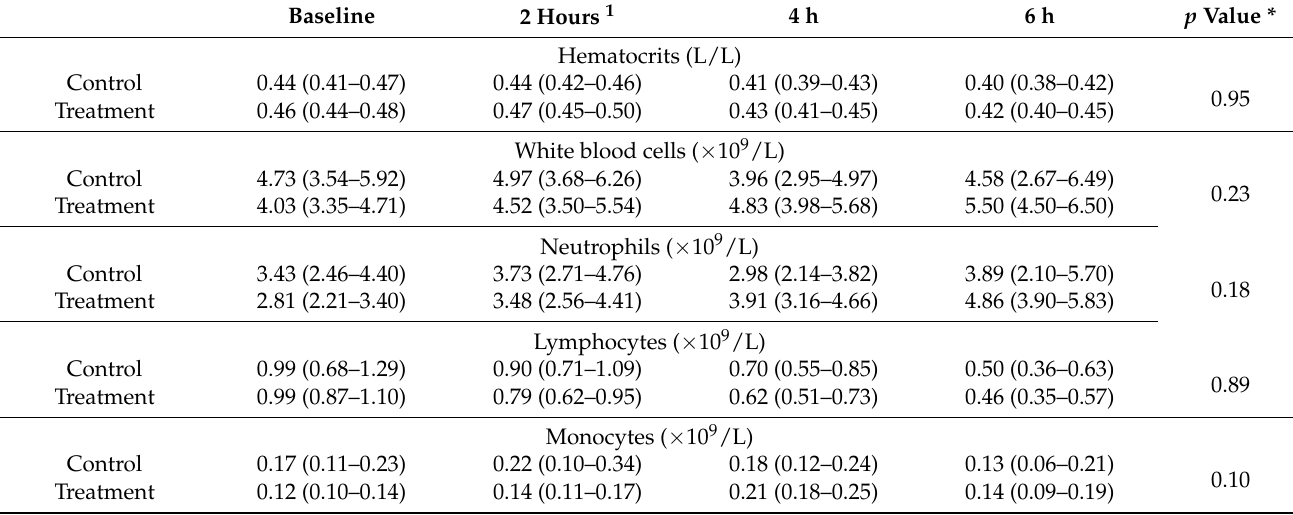
Table 1. Serial hematocrits and white blood cell counts in dogs receiving saline (control, n = 10) or deferoxamine (treatment, n = 10) at baseline and 2 hourly intervals after atraumatic hemorrhage and allogenic red blood cell transfusion. Data presented are means (95% confidence interval). 4